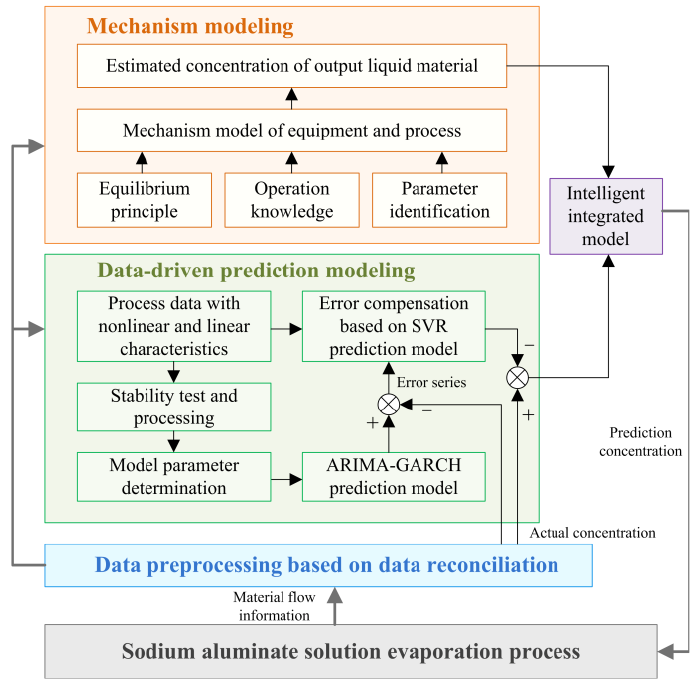
Figure 2. The structure of the new prediction modeling method.